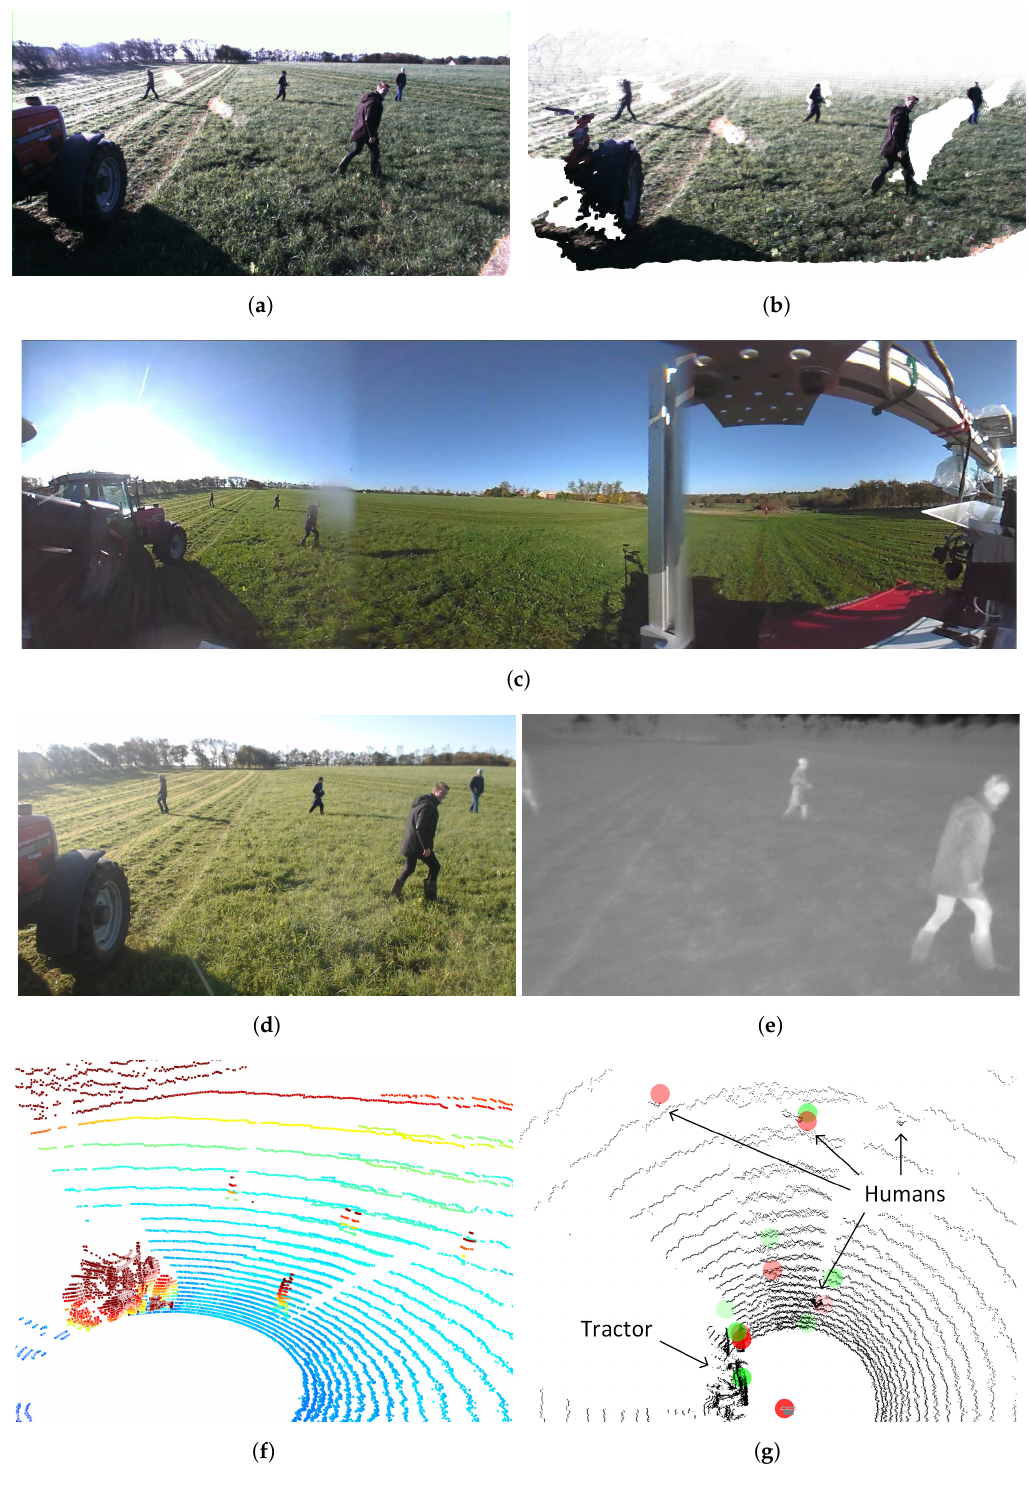
Figure 3. Example frames from the FieldSAFE dataset. ( a ) Left stereo image; ( b ) stereo pointcloud; ( c ) 360 ◦ camera image (cropped); ( d ) web camera image; ( e ) thermal camera image (cropped); ( f ) LiDAR point cloud (cropped and colored by height); ( g ) radar detections overlaid on LiDAR point cloud (black). Green and red circles denote detections from mid- and long-range modes,